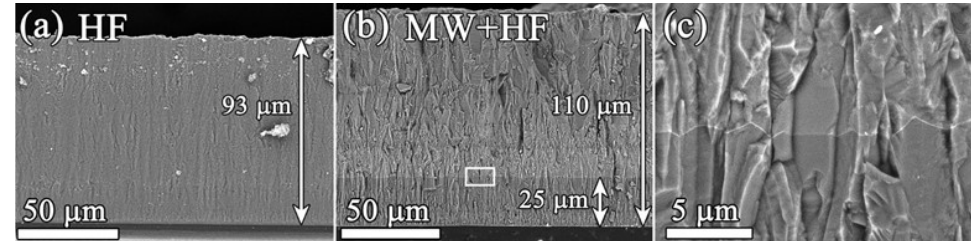
Figure 2. SEM images of cross-sections of HF CVD ( a ) and MW+HF CVD ( b ) films; ( c ) Enlarged image of MW → HF interface, marked in ( b ) with a white frame. Images were taken in the BSE mode of the microscope.